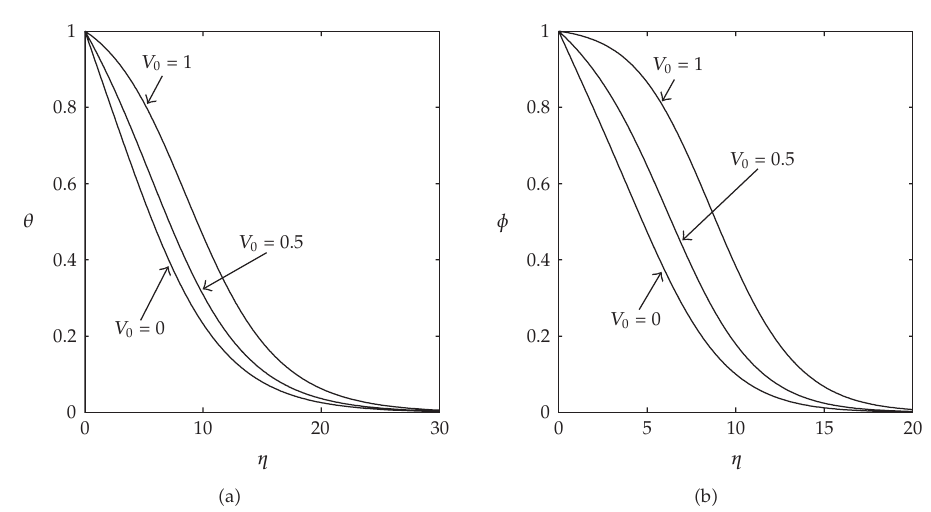
Figure 2: The variation of (cid:8) a (cid:9) the temperature distribution and (cid:8) b (cid:9) the concentration profiles with increasing injection parameter numbers with ξ (cid:7) 5 , Gr (cid:7) Gr c (cid:7) 1 , Pr (cid:7) 0 . 72 , Sc (cid:7) 1 , R (cid:7) 1 .